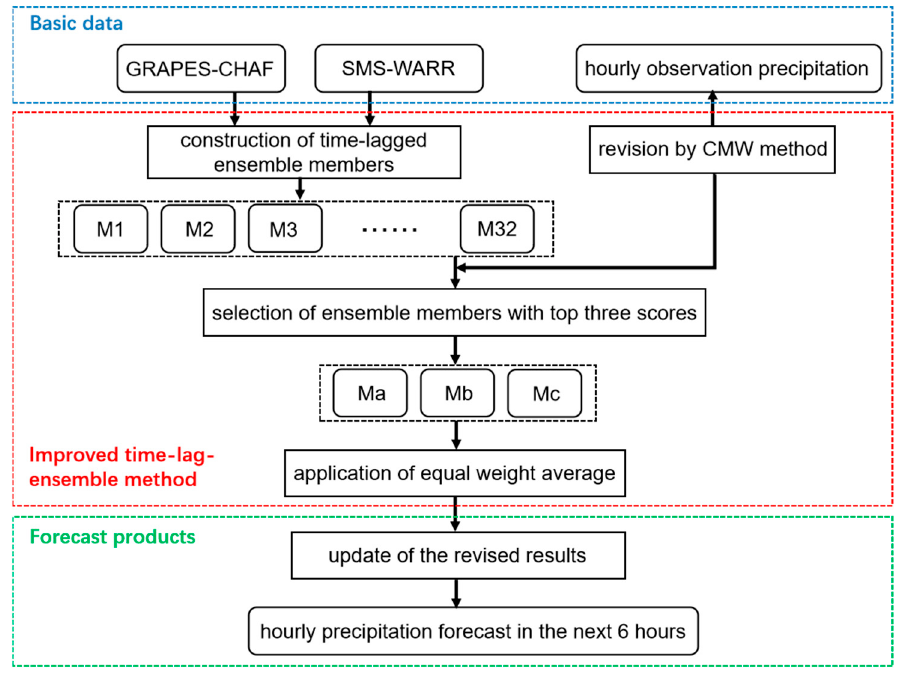
Figure 4. Schematic diagram of the optimal integration method of cross-magnitude weight for hourly precipitation forecasts.